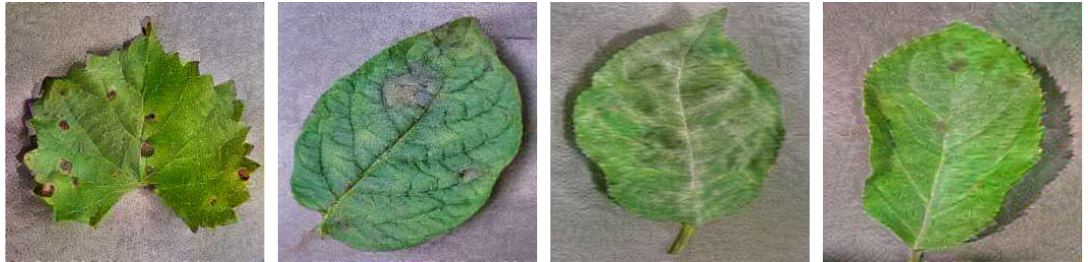
Figure 3. Sample augmented images using NST technique.